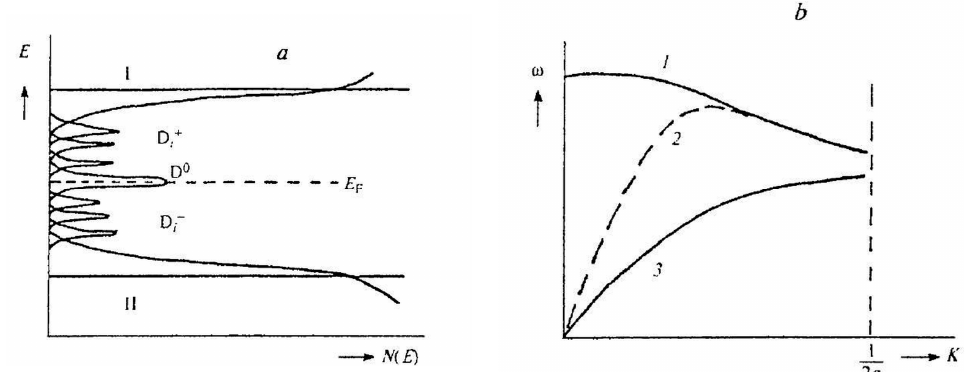
Figure 2. ( a ) A diagram of the density of defective states in an amorphous sample arising under the action of EWP. D i+ and D i − are sets of charged defective states; D 0 represents metastable molecules. ( b ) typical dispersion curves for the optical (1), soft (2) and acoustic (3) branches of the oscillation spectrum when they overlap ( ω is the frequency, a is the lattice constant, k is the wave number). These effects lead, possibly, to the appearance of quasiparticles associated with local vibrations of the lattice of a solid body [46,47]—polaritons and polarons, which almost completely absorb the energy of electromagnetic radiation (ER) quanta [38]. When the critical concentration of dipoles, e -K and ER quanta is reached, a self-induced correlation occurs between the dipole moments. All this can be compared with the well-studied pro- cesses of SR at optical and hypersonic frequencies [47]. Thus, in [4], the concept of a dipole scheme of mechanochemical reactions carried out under the influence of EWP, i.e., an electromagnetic–mechanical dipole (EMD). This process follows the equation ω = V EW / λ EW = c/ λ EMW , where ω is the dipole oscillation frequency, V EW and c are elastic and electromag- netic wave velocities and λ EW and λ EMW are elastic and electromagnetic wavelengths emit- ted by the dipole. In addition, it was shown in [4] that the introduction of quasiparticles, such as polaritons, into the scheme of mechanochemical processes, their energy consisting partly of electromagnetic energy and partly of the energy of elastic excitation of the me- dium (polaritons are formed as a result of the interaction of photons with optical phonons, excitons and magnons), allows us to understand where in mechanochemical processes is the missing Joule heat—that is, how the mechanochemical and thermal processes differ from each other. The concept of an electromagnetic–mechanical dipole, in addition to the previously proposed “convection” model of mechanochemical reactions, quite realistically describes mechanochemical reactions under the action of EWP and, probably, mechanochemical re- actions in general [4,11]. Indeed, if we assume that the elastic waves initiating the appear- ance of EMD are solitons (dislocation can be considered as a one-dimensional soliton), then the general scheme of a mechanochemical reaction looks similar to the following: S → EMD → e − K , (h ω ) p , M + , M* → stable products where S is a soliton, EMD is an electromagnetic–mechanical dipole, e − K is polaron (an elec- tron bound to phonons), ( h ω ) p is a polariton, M + is an ion and M* is an excited molecule. Such a scheme [4,11] agrees with and complements the mechanisms of phonon [12] and exciton dislocation [13] and the destruction of solids and ionic crystals, and also agrees with the ideas of the connection between the front of solid-phase reactions with internal mechanical stresses [14] and nonlinear waves [15]. All these assumptions led to the further logical development of research in the field of pulsed mechanochemistry. A polymer matrix (polyethylene, polystyrene, ethylene copolymer with vinyl ace- tate) doped with 3,6-di-tert-butyl-quinone and 3,6-di-tert-butyl-pyrocatechin and chro- mium acetylacetonate (or chromium carbonyl) was used as an example of systems [43] in